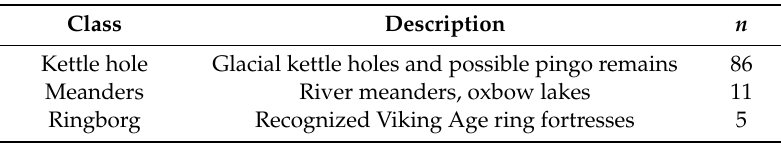
Table 4. Examples of natural and anthropogenic features uses as training data for the subsequent classification for ring fortress (Ringborg) detection within Denmark.